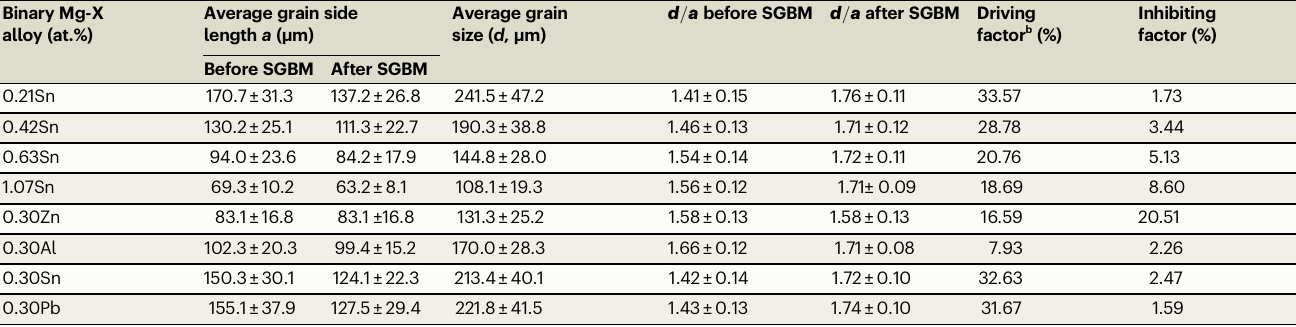
a Raw Experimental Data: Supplementary Information. b A ∝ a 2 for a truncated octahedron 59 . Notethat ( d = a ) Equilibrium =